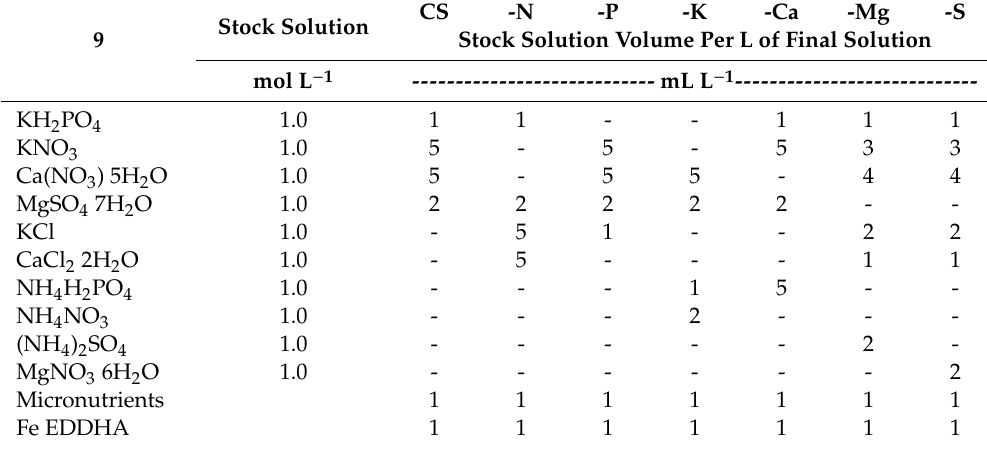
Table 1. Composition of the modified nutrient solution.